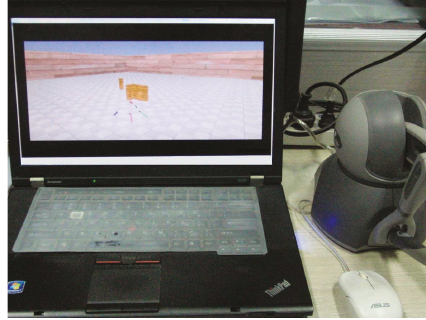
Figure 11: The experimental setup for the bilateral teleoperation